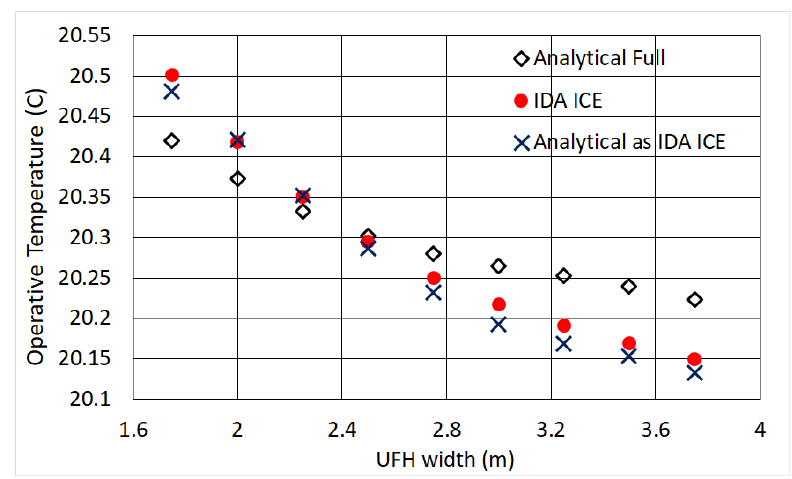
Figure 20. Operative temperature for a heated square portion of the ceiling.